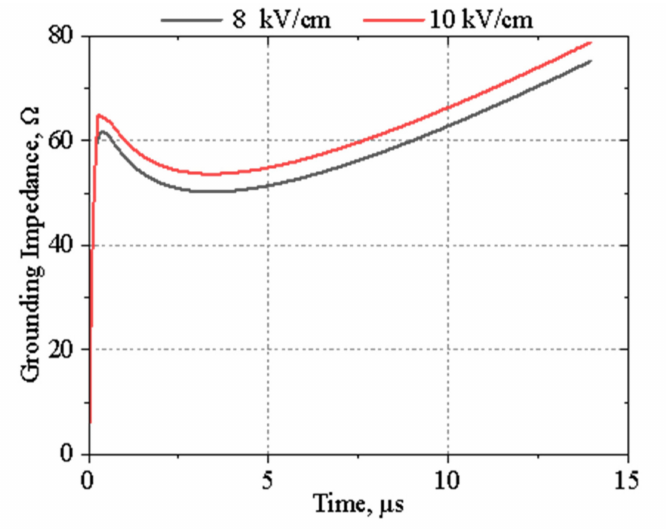
Figure 16. Grounding impedance produced in a vertical rod of 1.5 m, soil resistivity of 160 Ω m and a peak current of 2.35 kA.